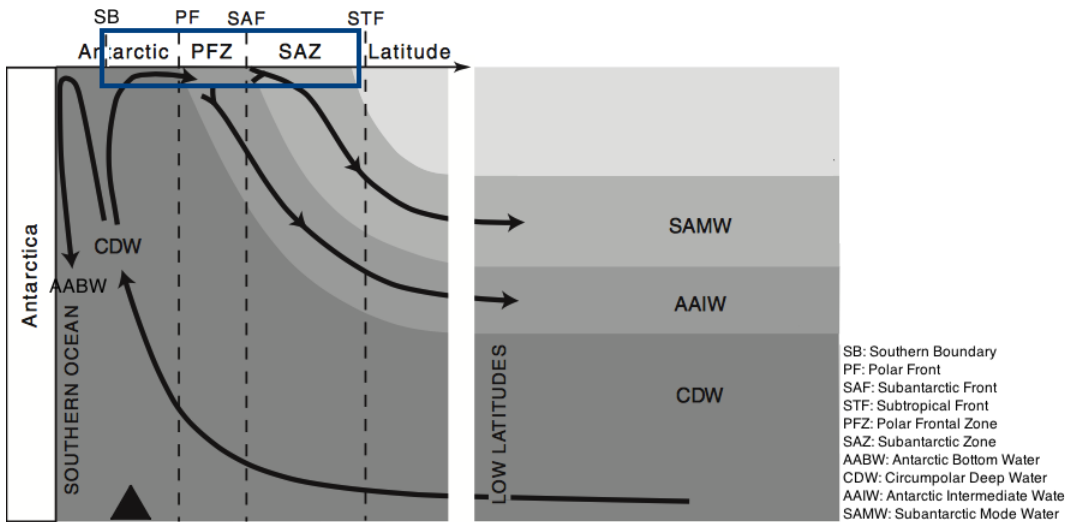
Figure 2. Circulation of main water masses in the Southern Ocean. Figure modified from Anderson et al. (2009). The box marks the region of